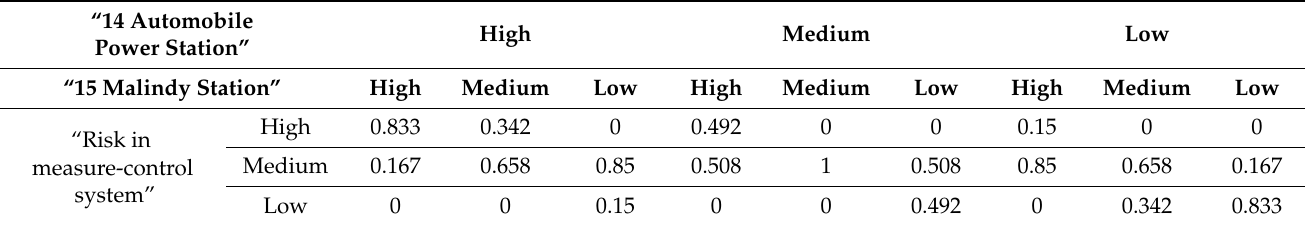
Table 6. CPT between the “Risk in measure-control system” node and its parent